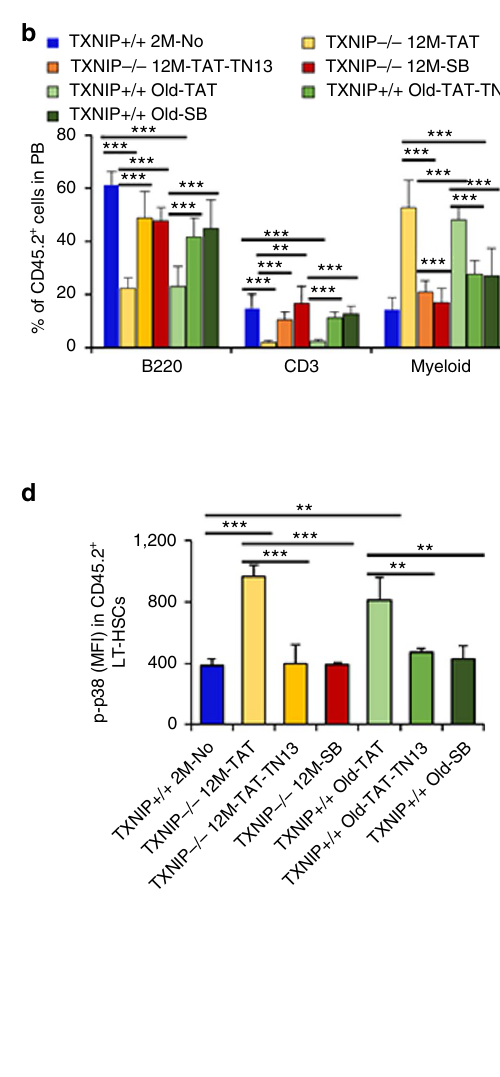
The HSC ageing is initiated by DNA damage such as deletions approaches were tried and showed the evidences of at least and mutation, epigenetic alterations and altered expression of certain key transcription factors. Deregulation of these intrinsic factors drive HSCs into physiological ageing with combinatorial effects of these alterations. This implies HSC ageing seems to be reversible and can be reprogrammed by modulating these key factors. The rejuvenation of aged HSCs is the reversal of these alterations and functional restoration of aged HSCs. Several NATURE COMMUNICATIONS|7:13674|DOI: